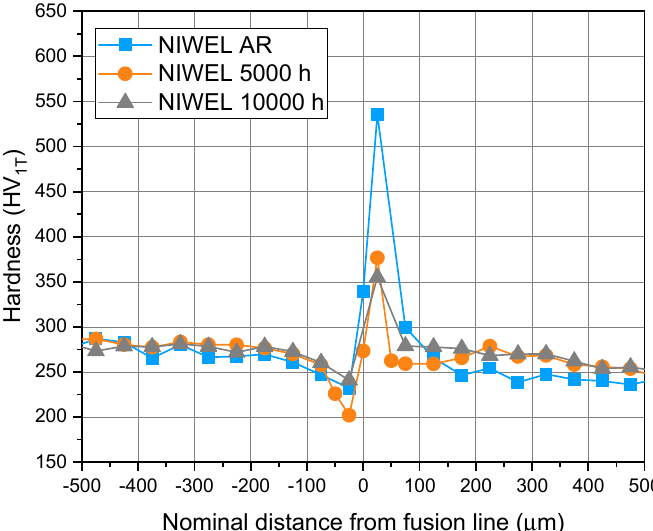
Figure 13. Comparison of the microhardness (350 mN) profiles of NIWEL AR, NIWEL 5000 h and NIWEL 10,000 h at the LAS/Alloy 52 weld metal interface.